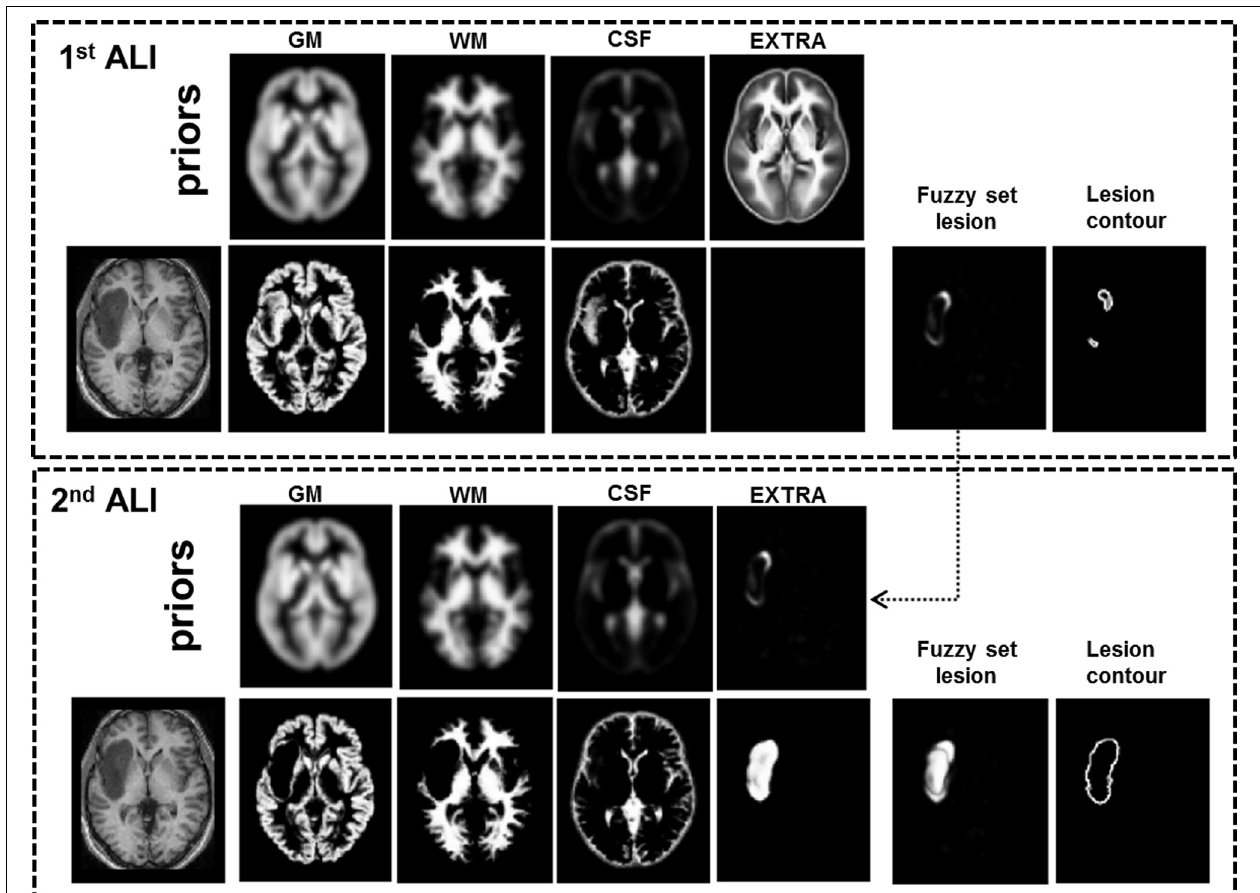
FIGURE 2 | Illustration of our recursive ALI procedure for patients with brain tumors. With standard ALI ( Top panel), the lesion is identified in the correct location, but not the total extent (see fuzzy set, lesion contour, and empty extra prior), because the